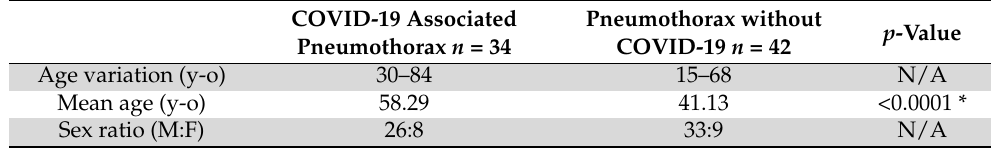
Table 1. Characteristics of the study groups.